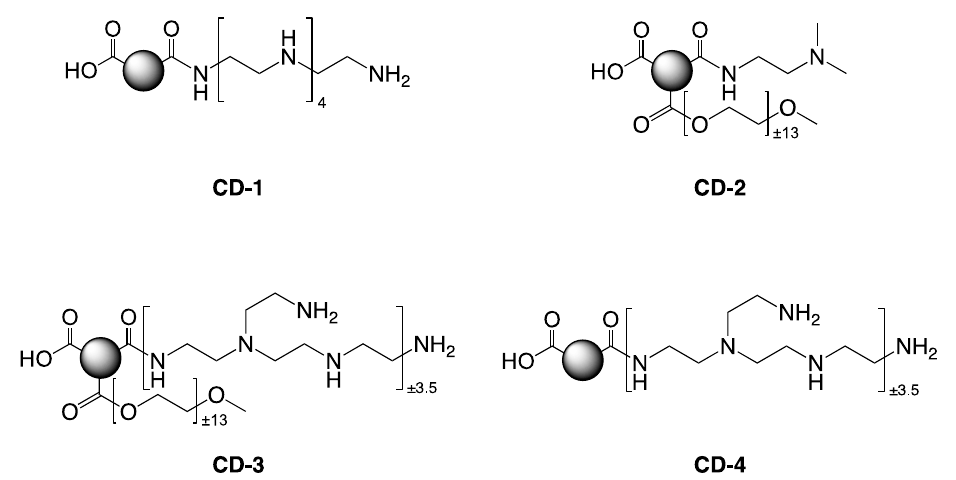
Figure 1. Structural features of the various carbon dots employed in the study. The nanoparticles CD-1 to CD-4 were generated through pyrolysis of citric acid (CA) in the presence of various passivation reagents presented in Materials and Methods and in Table 1.